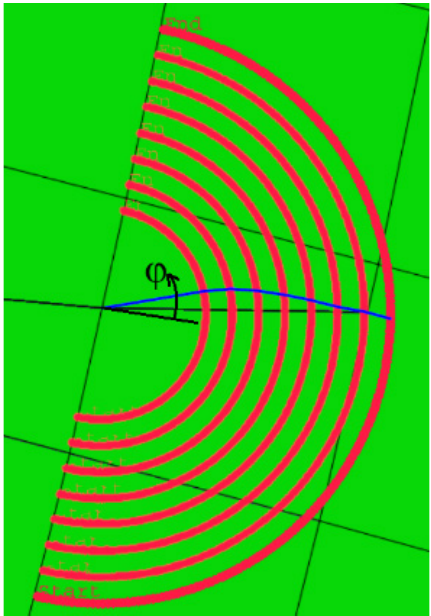
Figure 19: Predicted crack path found with own method.